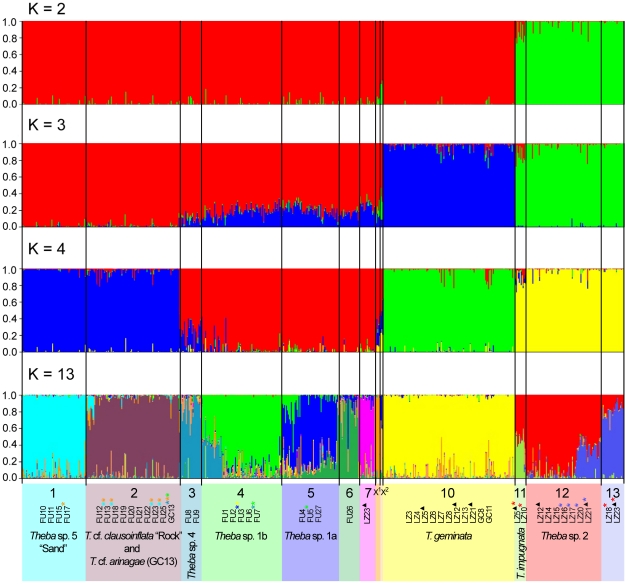
Results of the Structure analyses based on the AFLP data set.
Structure graphical outputs for K = 2, K = 3, K = 4, and K = 13 are shown. Each individual is represented by a vertical bar colored in proportion to their estimated ancestry within each cluster. X1 = Cluster 8 comprising all individuals of T. grasseti (GC3, GC4) and one individual of T. macandrewiana (SEL1); X2 = Cluster 9 comprising one individual of T. macandrewiana (SEL1) and two individuals of FU4; * = highly admixed populations, which also showed proportions of the cluster of the corresponding color; ▴ = mixed sample (i.e. samples are composed of two species).